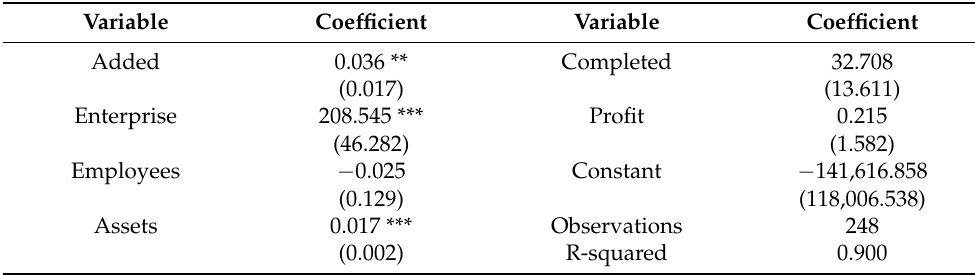
Table 2. Results of the regression